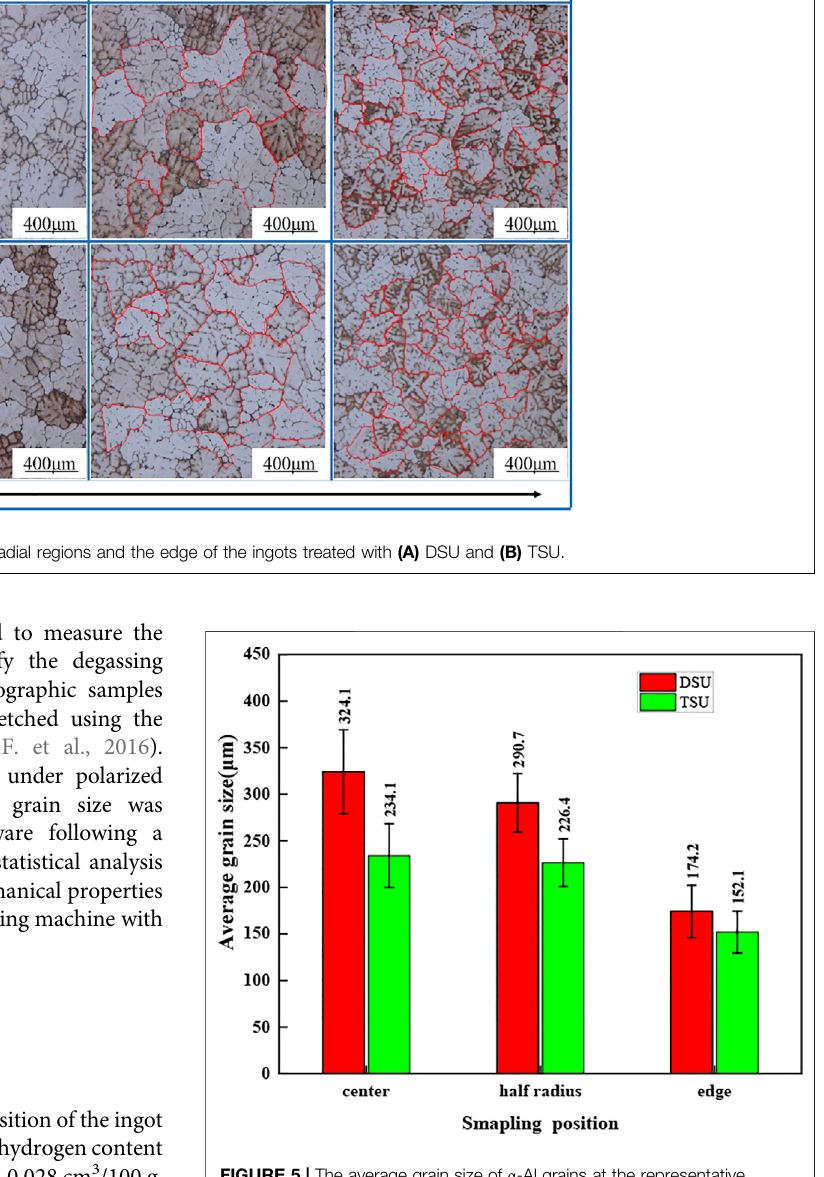
FIGURE 5 | The average grain size of α -Al grains at the representative positions of the ingots treated with DSU and